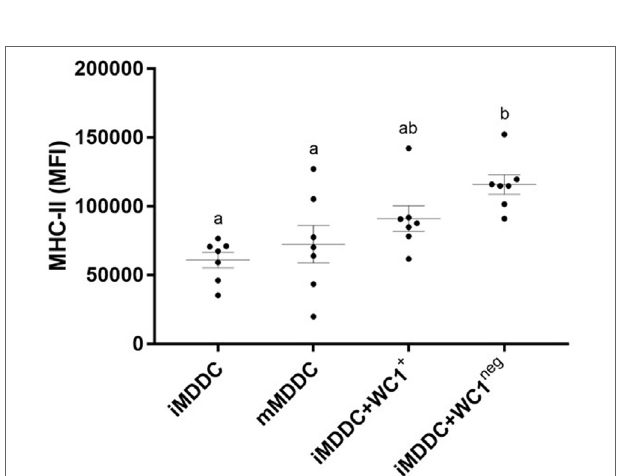
FigUre 8 | live Mycobacterium avium subspecies paratuberculosis ( Map ) was associated with significantly increased expression of major histocompatibility complex (Mhc)-i on immature monocyte- derived dendritic cell (iMDDc) + Wc1 neg . Infection with live Map was associated with significantly increased expression of MHC-I on iMDDC + WC1 neg . Median fluorescence intensity of MHC-I on iMDDCs, iMDDCs + WC1 + , and iMDDCs + WC1 neg . Results are individual animal data points and means ± SEM of seven animals. Different letters indicate statistically significant difference ( p < 0.05).